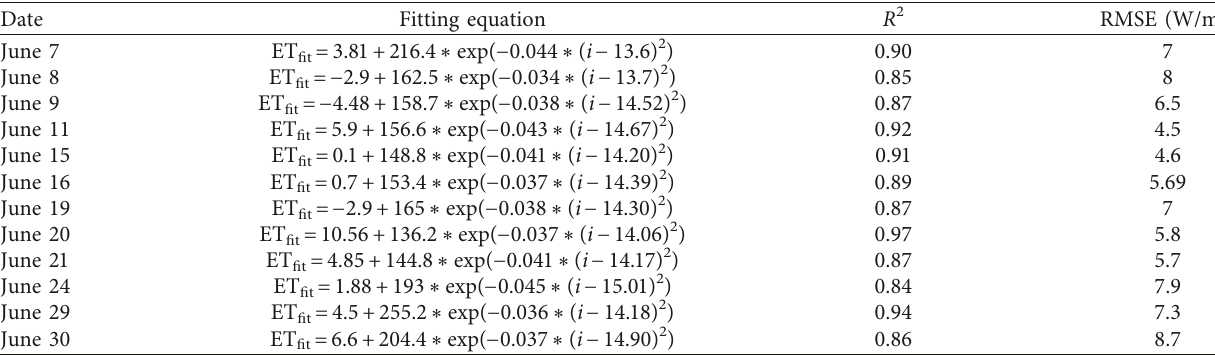
Figure 5: Gaussian fitting results on ET measurements at EC1 on cloud-free days in June 2012. Table 2: Gaussian fitting results on ET measurements at EC4 on cloud-free days in June